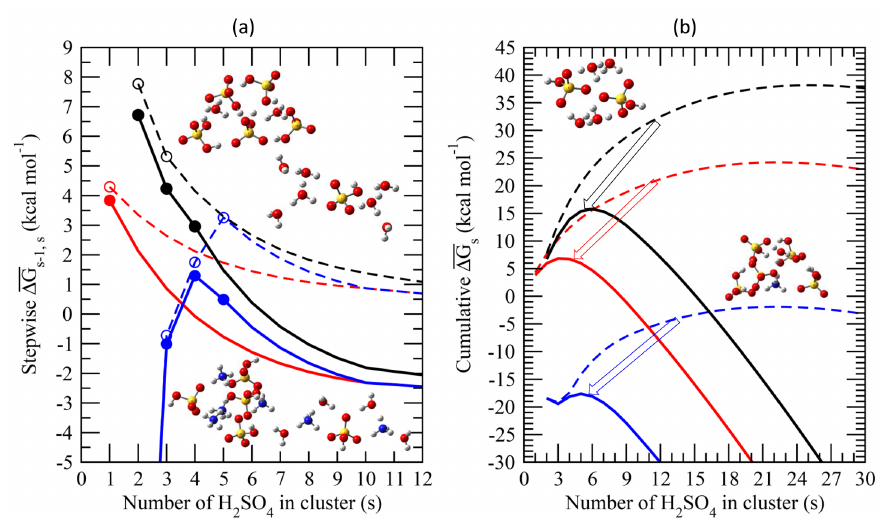
Figure 4. (a) Average stepwise Gibbs free energy change for the addition of one H 2 SO 4 molecule to form a neutral (black), positively charged (red), or negatively charged (blue) binary H 2 SO 4 –H 2 O (dashed lines or empty circles) or ternary H 2 SO 4 –H 2 O–NH 3 (solid lines or filled circles) cluster containing s H 2 SO 4 molecules ( (cid:49)G s − 1 ,s ). (b) Same as (a) but for the cumulative (total) Gibbs free energy change in each case. Filled and empty circles in (a) refer to (cid:49)G s − 1 ,s obtained using measurements and/or quantum-chemical calcula- tions. (cid:49)G s − 1 ,s for larger clusters with s ≥ 10, which approach the properties of the equivalent bulk liquid (20), is calculated using the capillarity approximation. Interpolation is used to calculate (cid:49)G s − 1 ,s for clusters up to s = 10 (Eq. 11). Calculations were carried out at T = 292K, RH = 38%, [H 2 SO 4 ] = 3 × 10 8 cm − 3 , and [NH 3 ] = 0.3ppb. The inset diagrams represent equilibrium geometries for the most stable isomers of selected binary clusters ((H 3 O + )(H 2 SO 4 )(H 2 O) 6 , (H 2 SO 4 ) 2 (H 2 O) 4 , and (HSO − )(H 2 SO 4 ) 4 (H 2 O) 2 ) and ternary clusters 4 ((NH + )(H 2 SO 4 )(NH 3 )(H 2 O) 4 , (HSO − )(H 2 SO 4 ) 4 (H 2 O)(NH 3 ), (H 2 SO 4 ) 4 (NH 3 ) 4 4 4